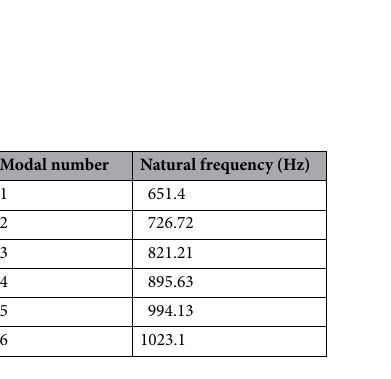
Table 6. Natural frequency table of sixth-order